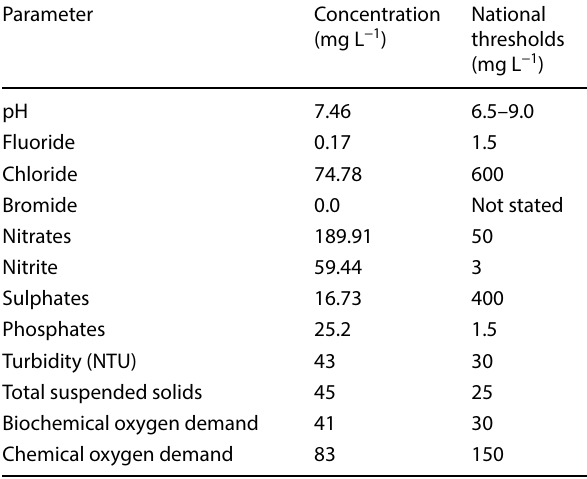
Table 2 The physiochemical parameters of wastewater used in this study